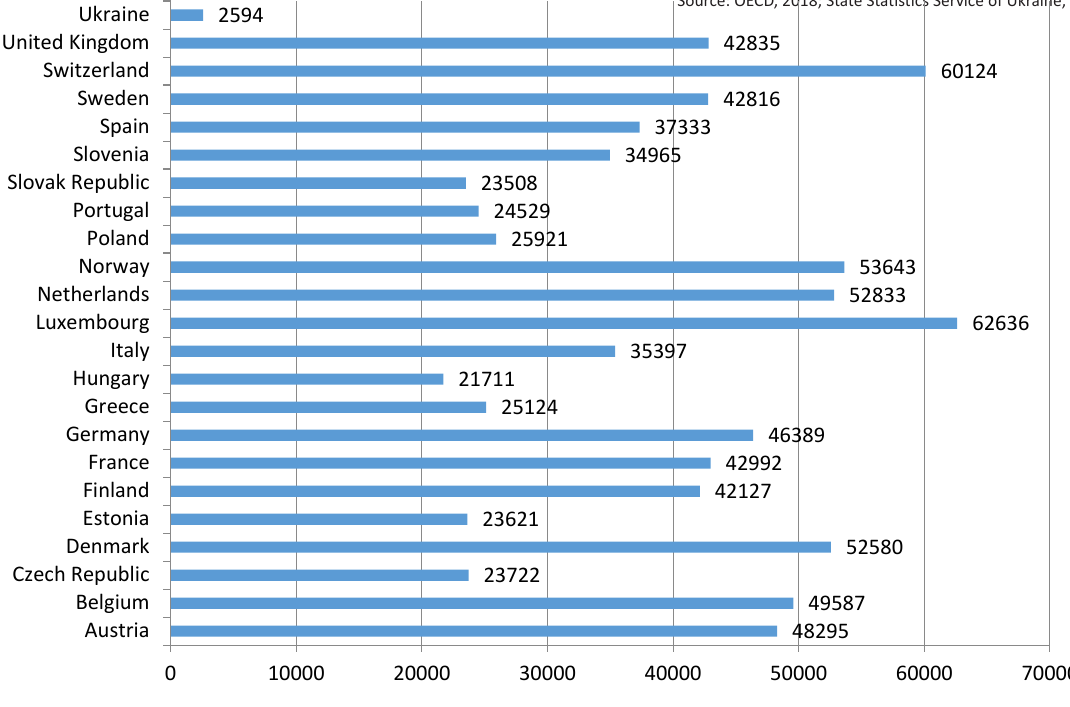
Table 1. Dynamics of social indicators in Ukraine in 2014–2017